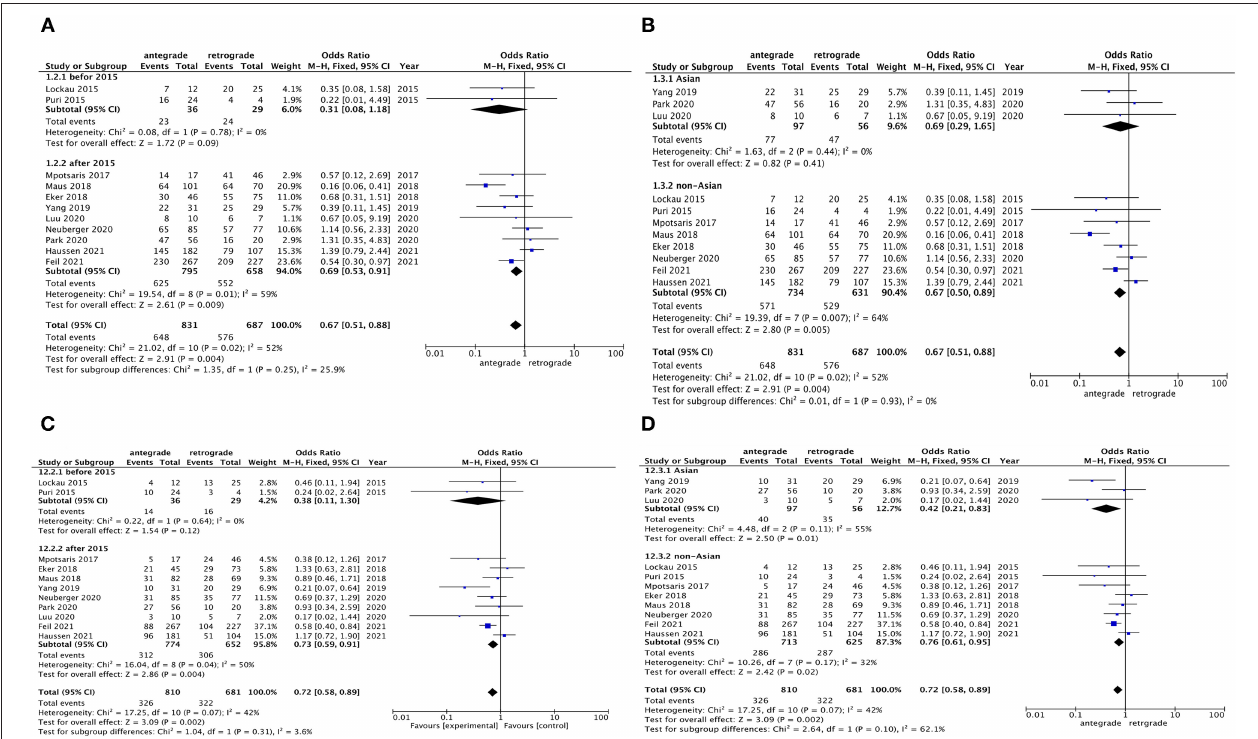
FIGURE 3 | Subgroup analysis for heterogeneous outcomes of antegrade and retrograde groups based on article published year and the region of data source of the patients. (A,B) successful reperfusion (TICI 2b − 3) and (C,D) favorable outcomes (90-day mRS